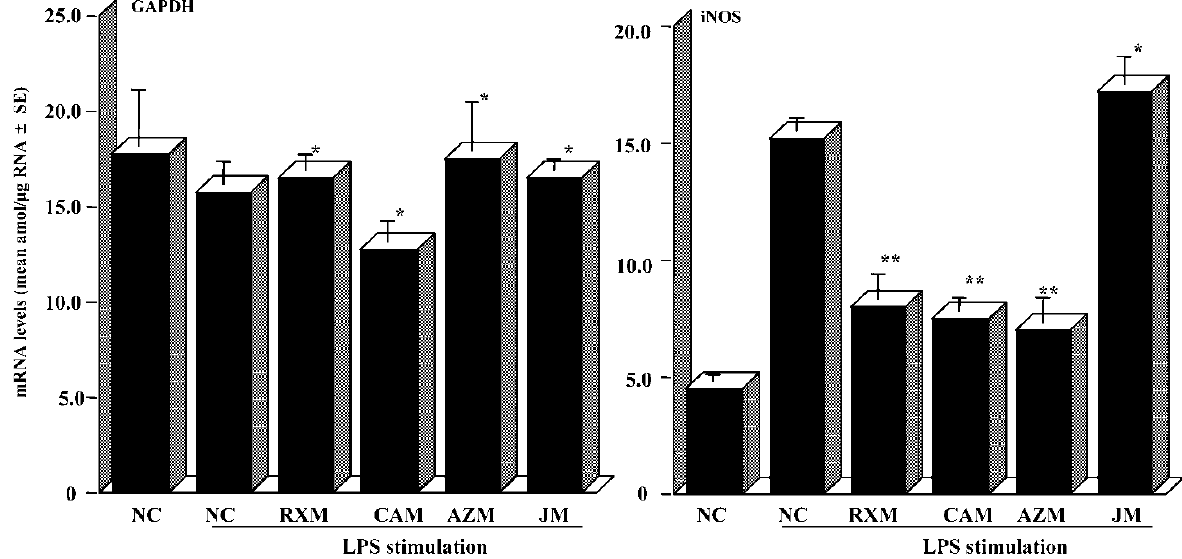
FIG. 6. Influence of macrolide antibiotics on iNOS mRNA expression in lung tissues. ICR mice were orally administered with either RXM, AZM, CAM, or JM once a day for 4 weeks. The mice were then injected intraperitoneally with 5.0 mg/kg of LPS, and lung tissue was obtained 6 h later for mRNA expression. NC, normal control. * Not significant compared with normal controls with LPS injected; ** significant compared with normal controls with LPS